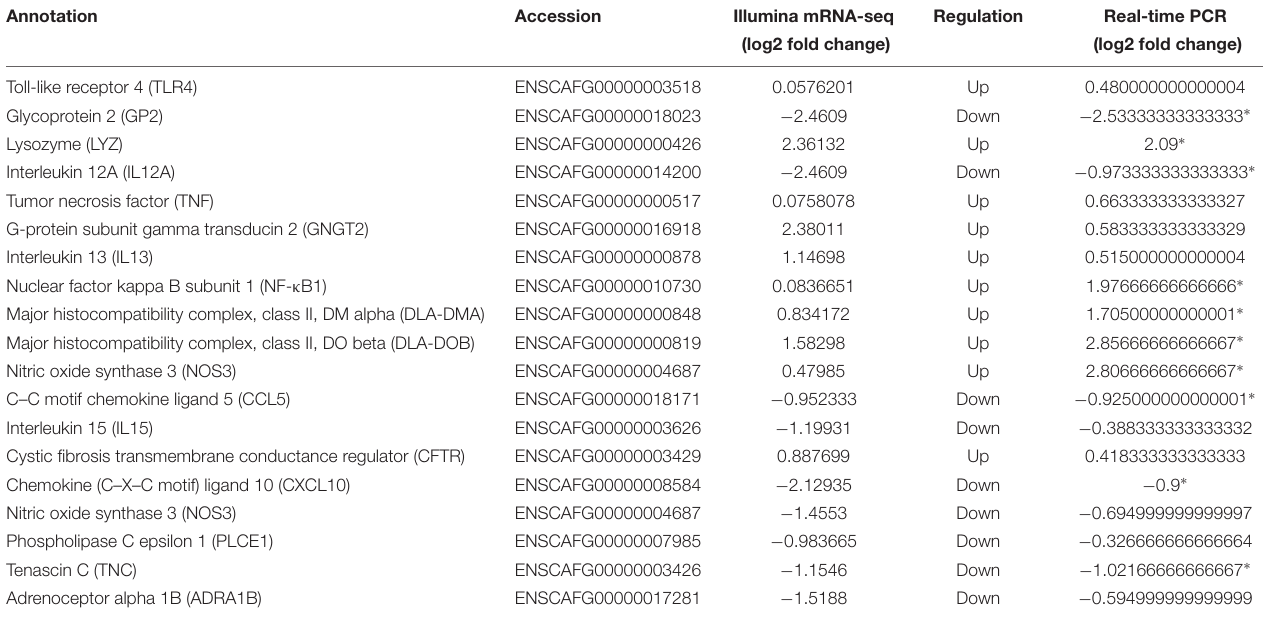
TABLE 2 | Relative mRNA expression of 10 selected DEGs as revealed through mRNA-Seq and Quantitative real-time